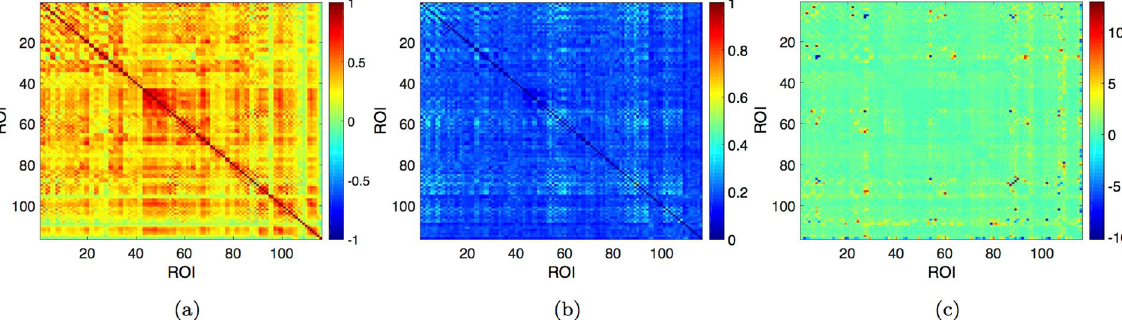
Figure 1. Inter-subjects variability. ( a ) Mean, ( b ) standard deviation and ( c ) coefficient of variation of pairwise correlation values across the 40 subjects involved in the